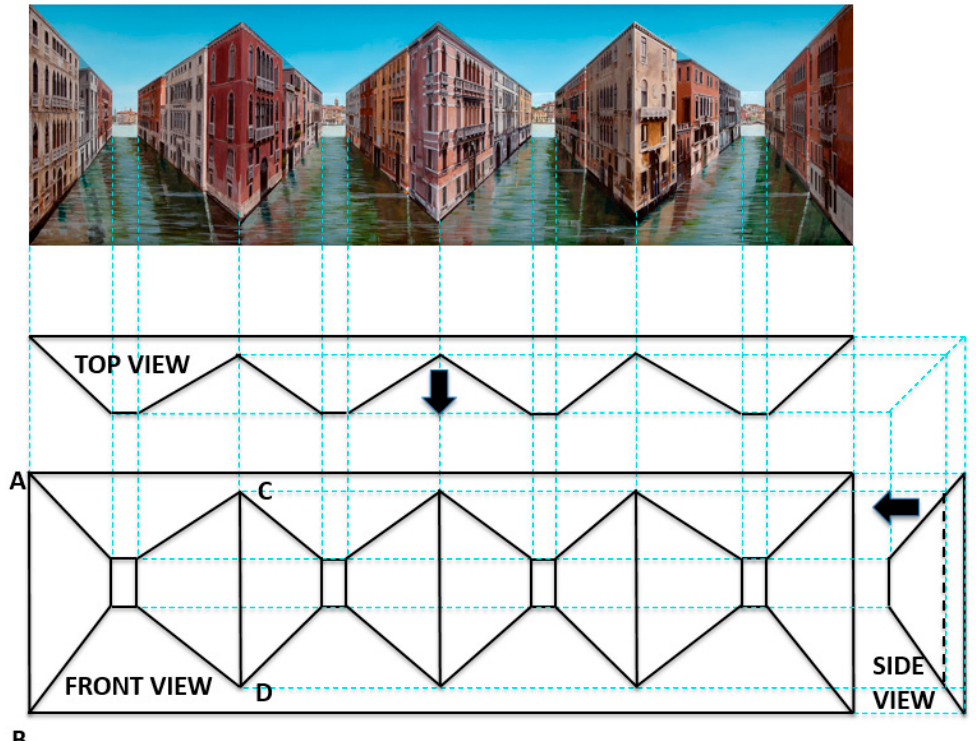
Figure 2. “Making Space” (2016). Top panel : Front view of painted piece. Middle panel : Top view. Bottom left panel: Unpainted front view. Bottom right panel: Side view. Thick arrows point in the direction of the viewer. See text for details.